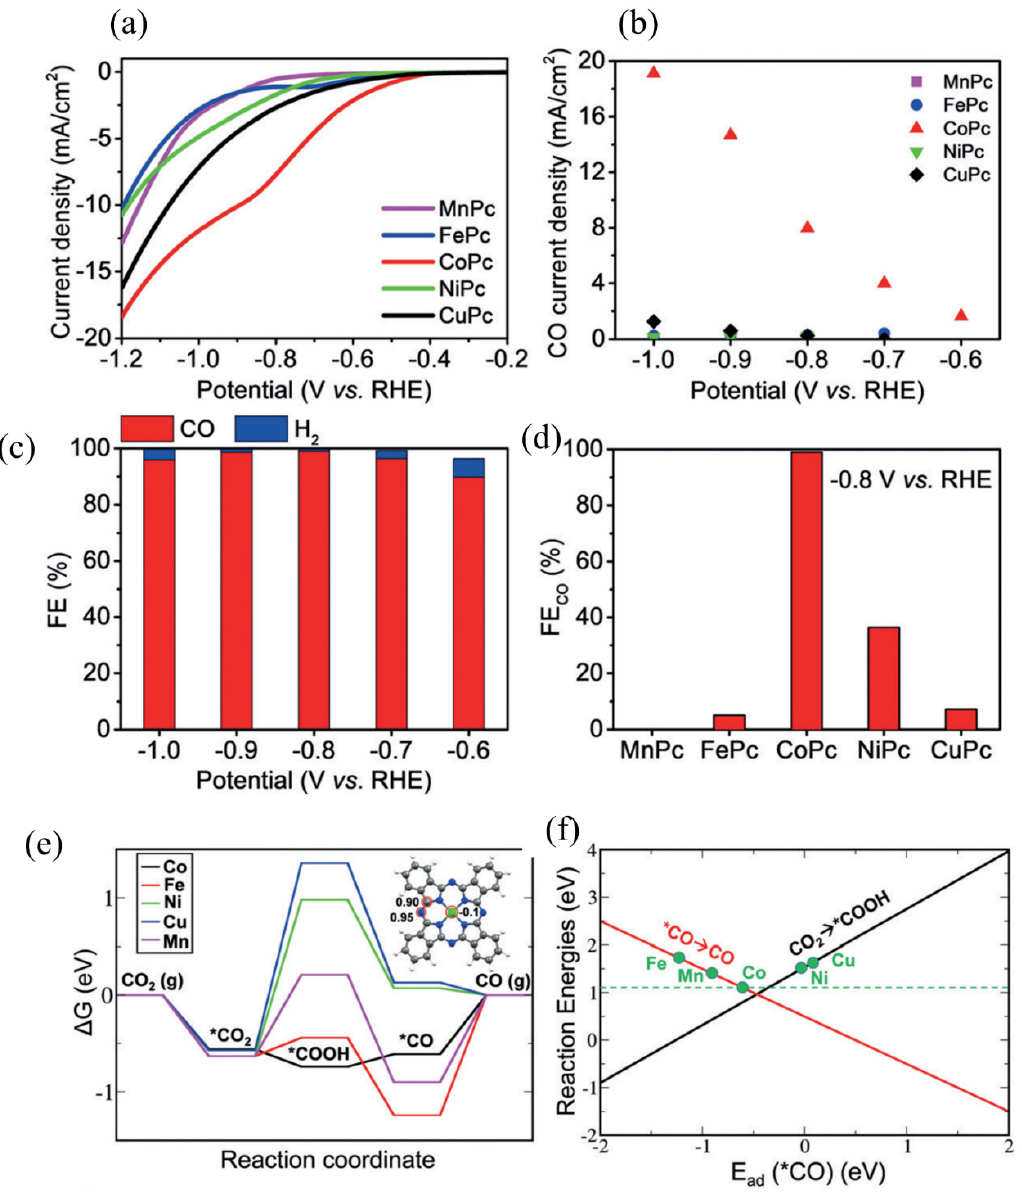
Figure 6. ( a ) Linear-sweep voltametric (LSV) tests in CO 2 -saturated electrolyte. ( b ) CO current density of MePcs at various potentials. ( c ) Faradaic efficiency of CO and H 2 formation at different potentials for the CoPc sample. ( d ) Faradaic efficiency of CO formation at − 0.8 V versus RHE for the different MePc samples. ( e ) The calculated free-energy diagram for all the MePc electrodes. The inset shows the adsorption energy of *COOH (unit eV) on different sites of CoPc. ( f ) Fitted *CO desorption and *COOH formation trends over the five MePc electrodes. Reprinted from [92], Copyright (2018), with permission from Wiley.